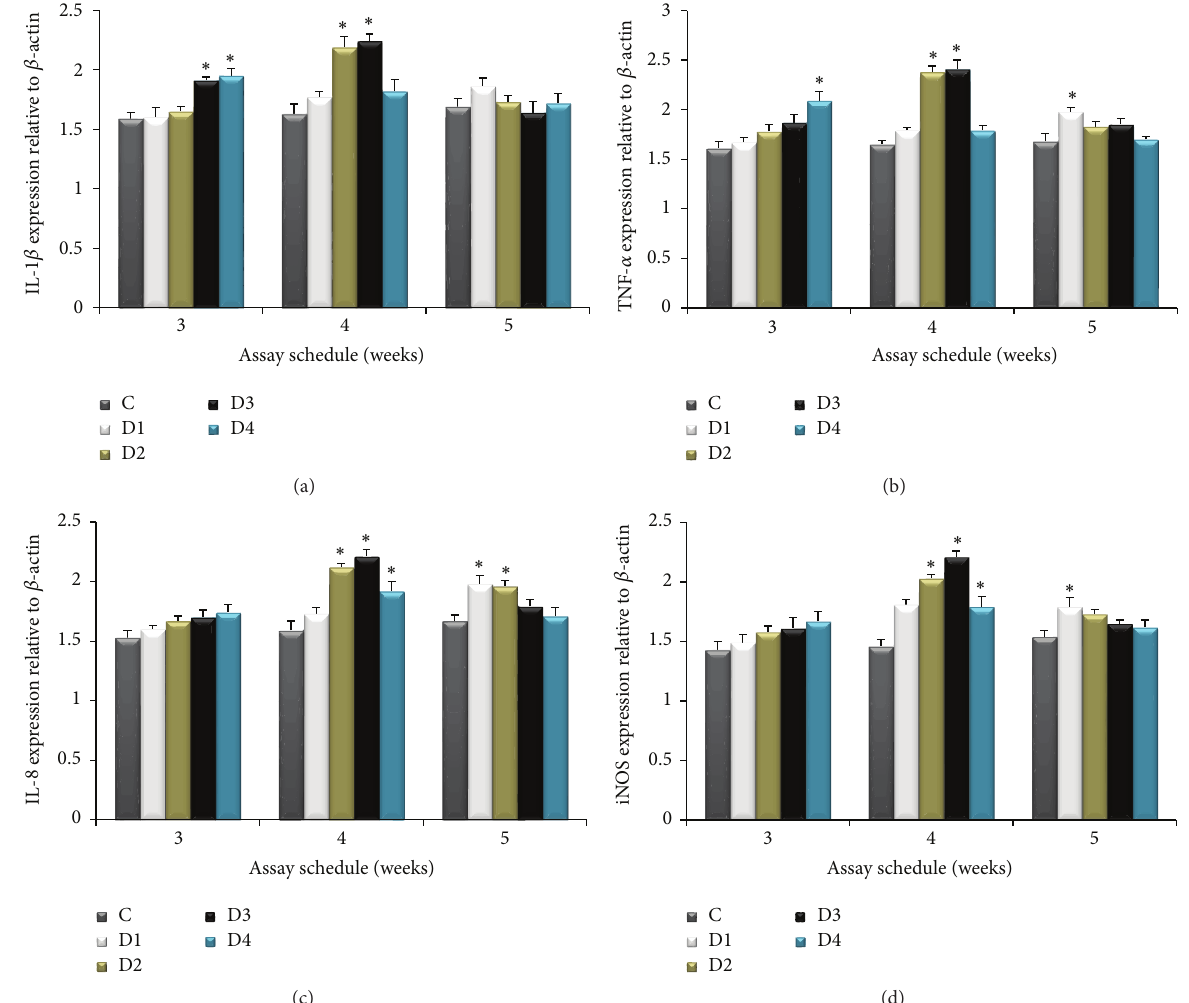
Figure 2: The relative mRNA expression of IL8, IL-1 𝛽 , iNOS, and TNF- 𝛼 in the head kidney of Labeo rohita at the end of weeks 3, 4, and 5 of feeding with graded level of CBP. Bars represent the mean ± SEM and asterisks represent levels of significant differences compared to the control ( 𝑃 < 0.05 ). Note: C (basal diet); D1 (basal diet + 0.1% CBP); D2 (basal diet + 0.2% CBP); D3 (basal diet + 0.3% CBP); D4 (basal diet + 0.4%